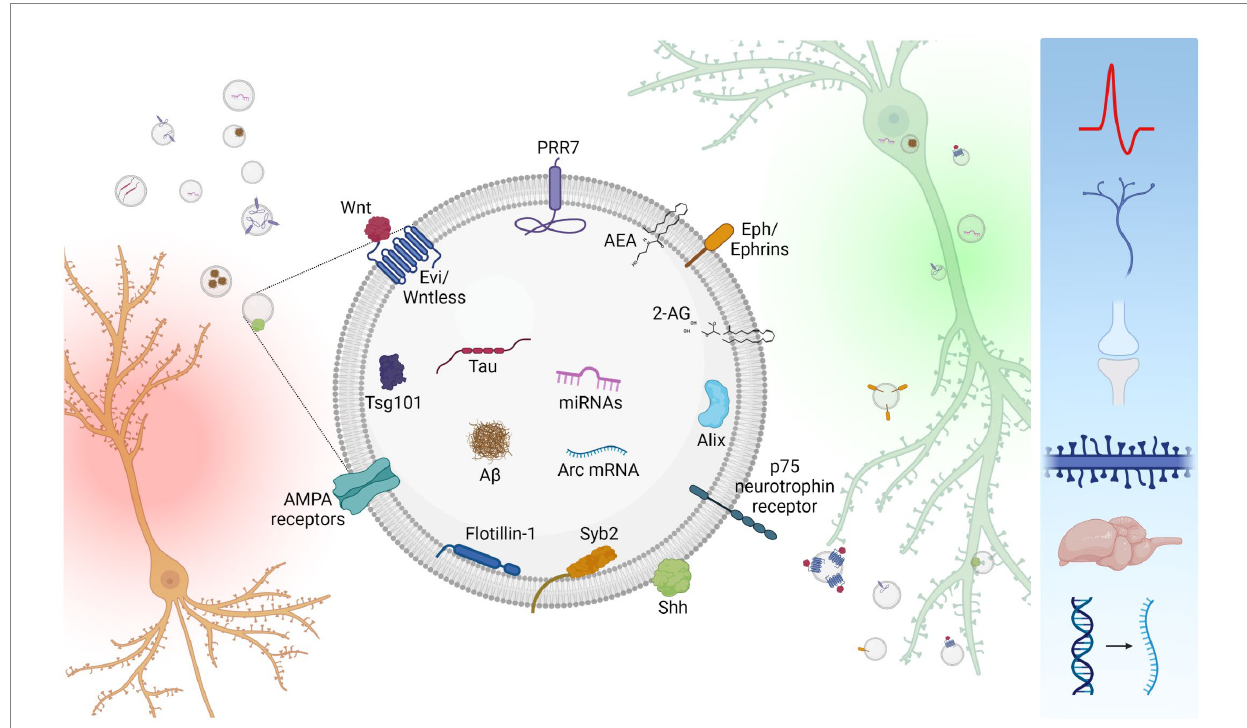
FIGURE 1 Inter-neuronal signaling mediated by neuronal small EVs. Neurons ( orange ) secrete small EVs carrying a variety of signaling molecules ( center ). However, neuronal small EVs are heterogenous in size and molecular composition, and single small EVs unlikely carry all these molecules. Secreted small EVs are absorbed by recipient neurons ( green ) either via endocytosis or membrane fusion. Uptaken small EVs affect a variety of cellular processes including neuronal firing, axon guidance, synapse formation, dendritic spine maintenance, synapse elimination, brain development, and mRNA expression ( right blue box ). Created with